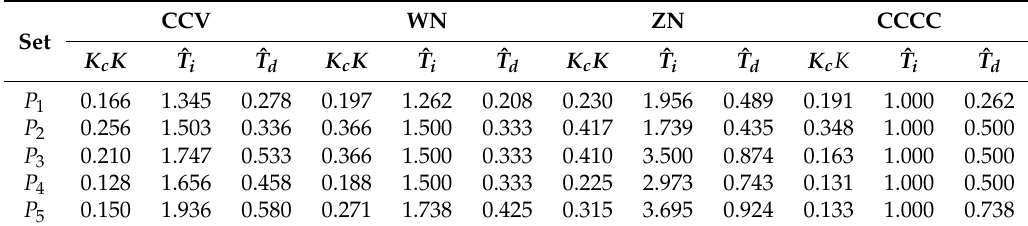
Table 4. Controller parameters for sets P 1 , P 2 , P 3 , P 4 , P 5